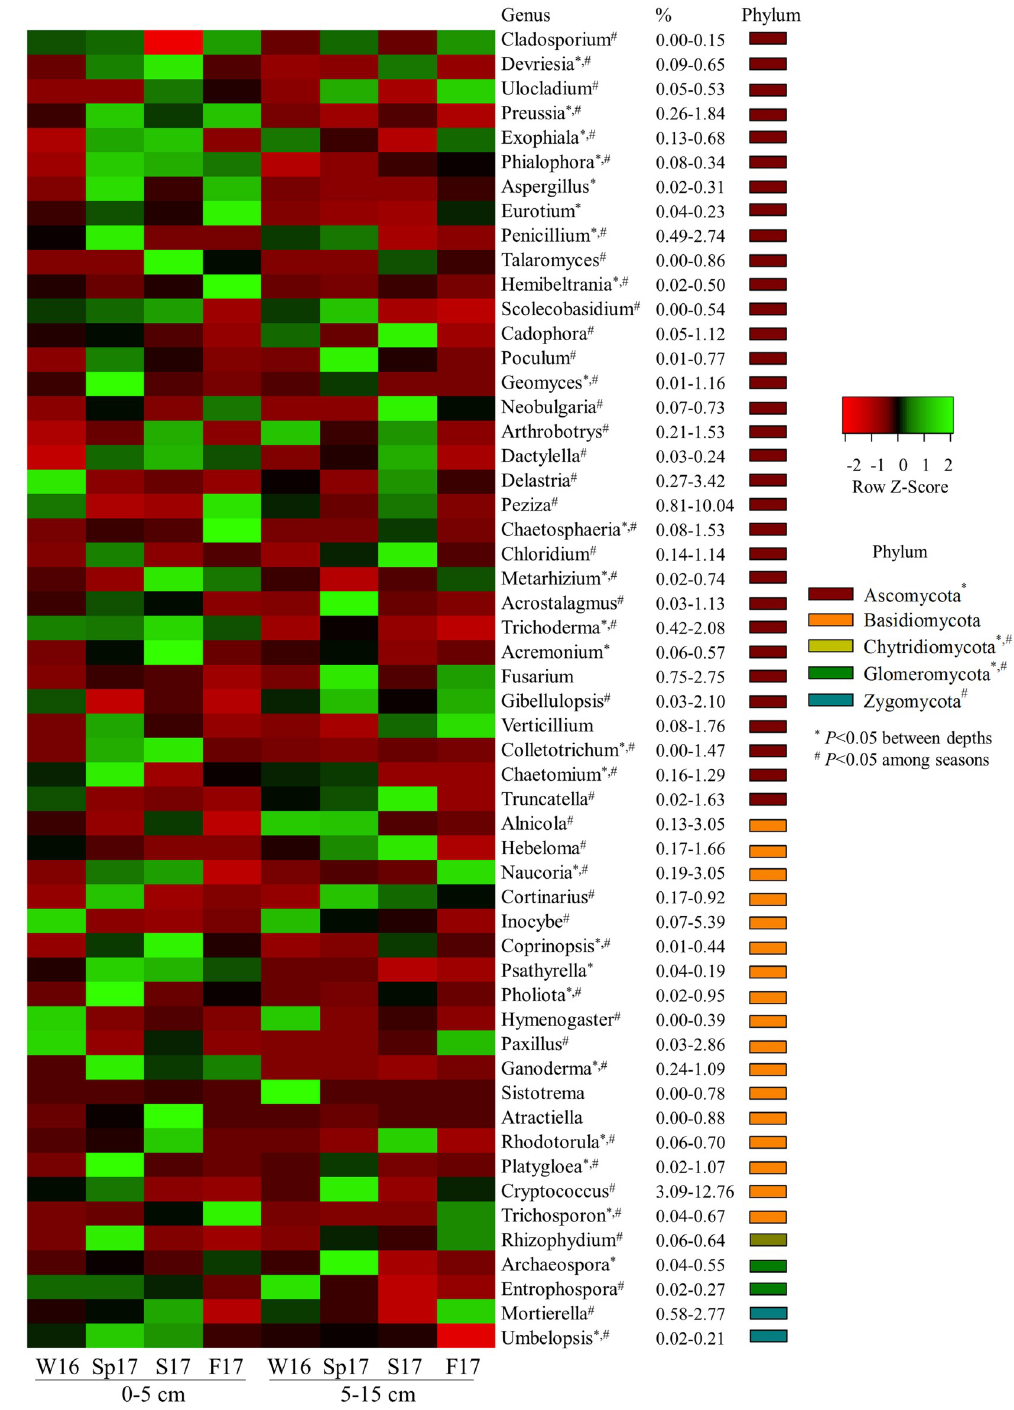
Fig 7. A heat map of relative abundance of fungal dominant taxonomic groups at genus level (average abundances > 0.1%) that were significantly variable between two soil depths (0–5 and 5–15 cm) and over four sampling seasons (Winter 2016, Spring, Summer, and Fall 2017). Asterisks indicate significant difference between two soil depths (0–5 and 5–15 cm) at α = 0.05. Number signs indicate significant difference over four sampling seasons (Winter 2016, Spring, Summer, and Fall 2017) at α =